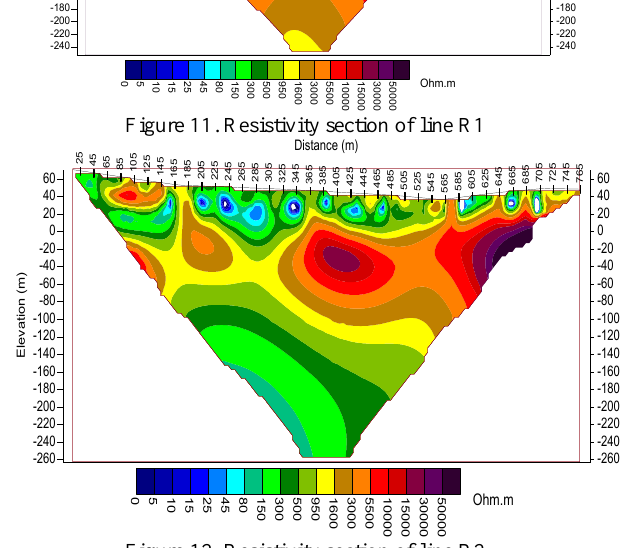
Figure 11. Resistivity section of line R1